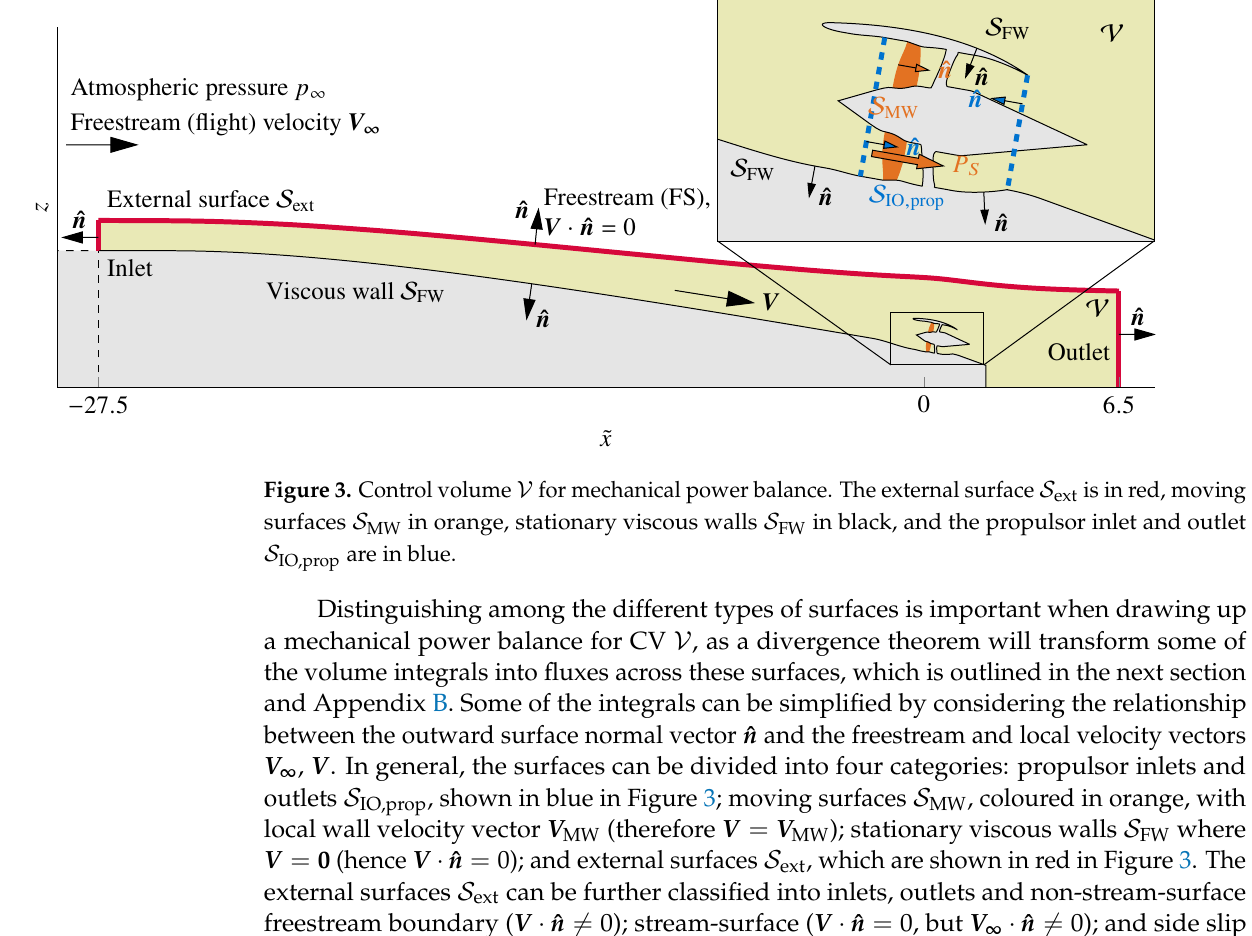
in black, and the propulsor inlet and outlet S FW